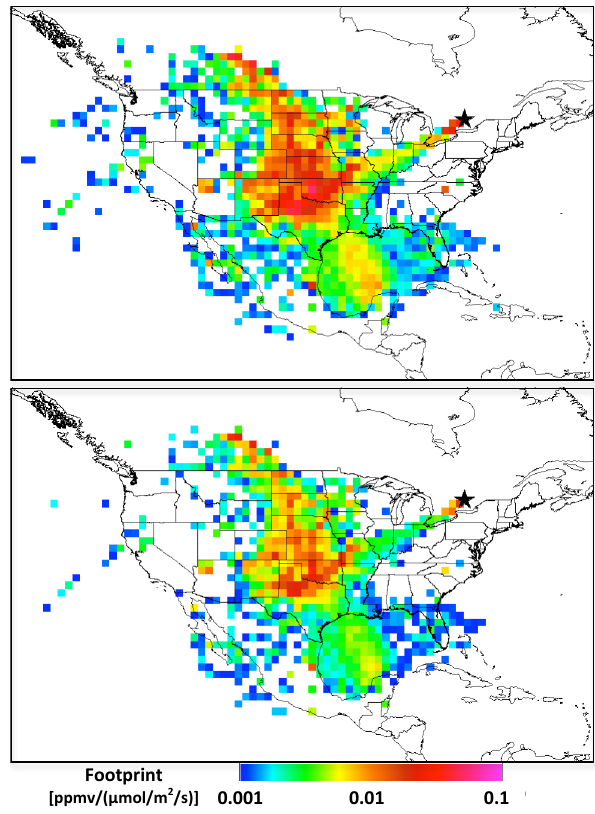
Figure 4. Footprint maps for one simulated ASCENDS mea- surement location (marked by black star) on 1 January 2007 at 18:00UTC, integrated over 10 days and convolved over the 500– 14500mAGL range with two candidate ASCENDS weighting functions: the CO 2 laser lines at 2.05µm (top) and 1.57µm (bot- tom). Note that the native temporal resolution of the footprints is 3h; the 10-day integral in this figure is for illustrative purposes only. Only footprints over land are used in the